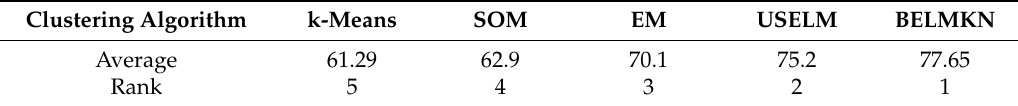
Table 4. Average clustering accuracy and general ranking of the techniques of all datasets. Clustering Algorithm